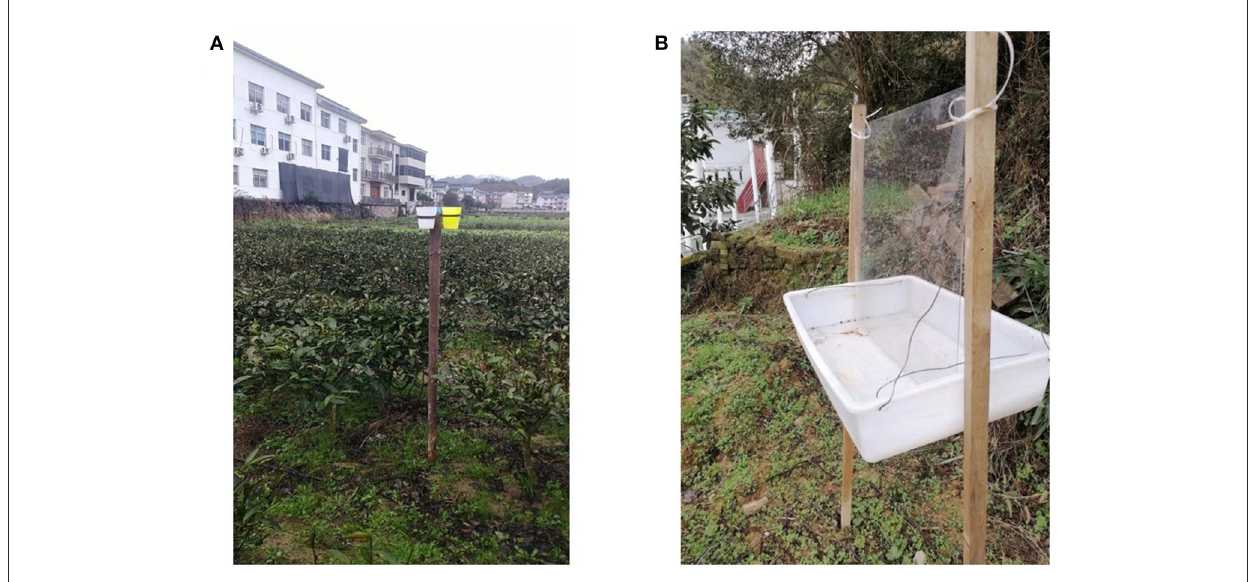
FIGURE2 Examples of pan trap (A) and flight interception trap (B)